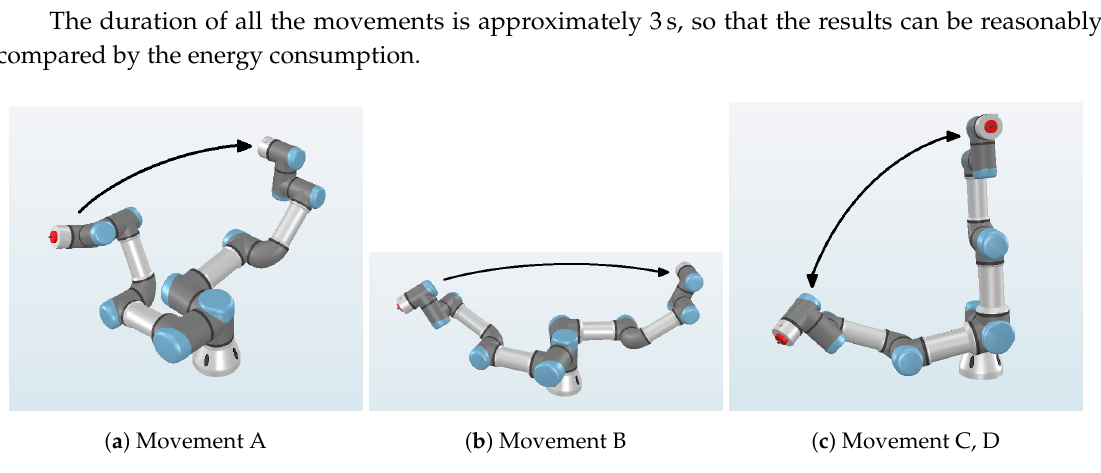
Figure 8. End positions of the optimized